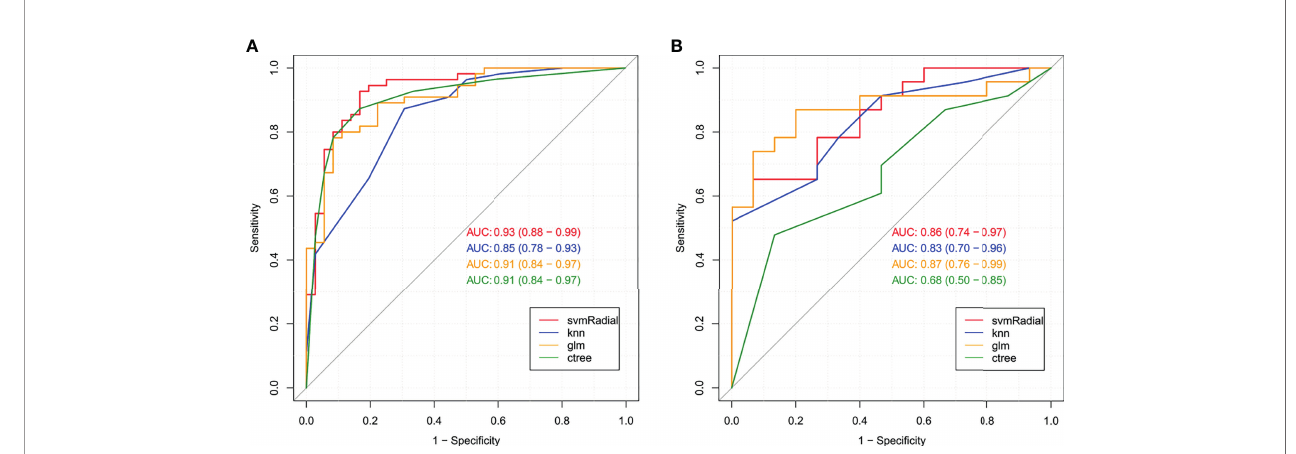
FIGURE 3 | Receiver operating characteristic (ROC) curves for the four classi fi cation machine learning models in the training set (A) and test set (B)